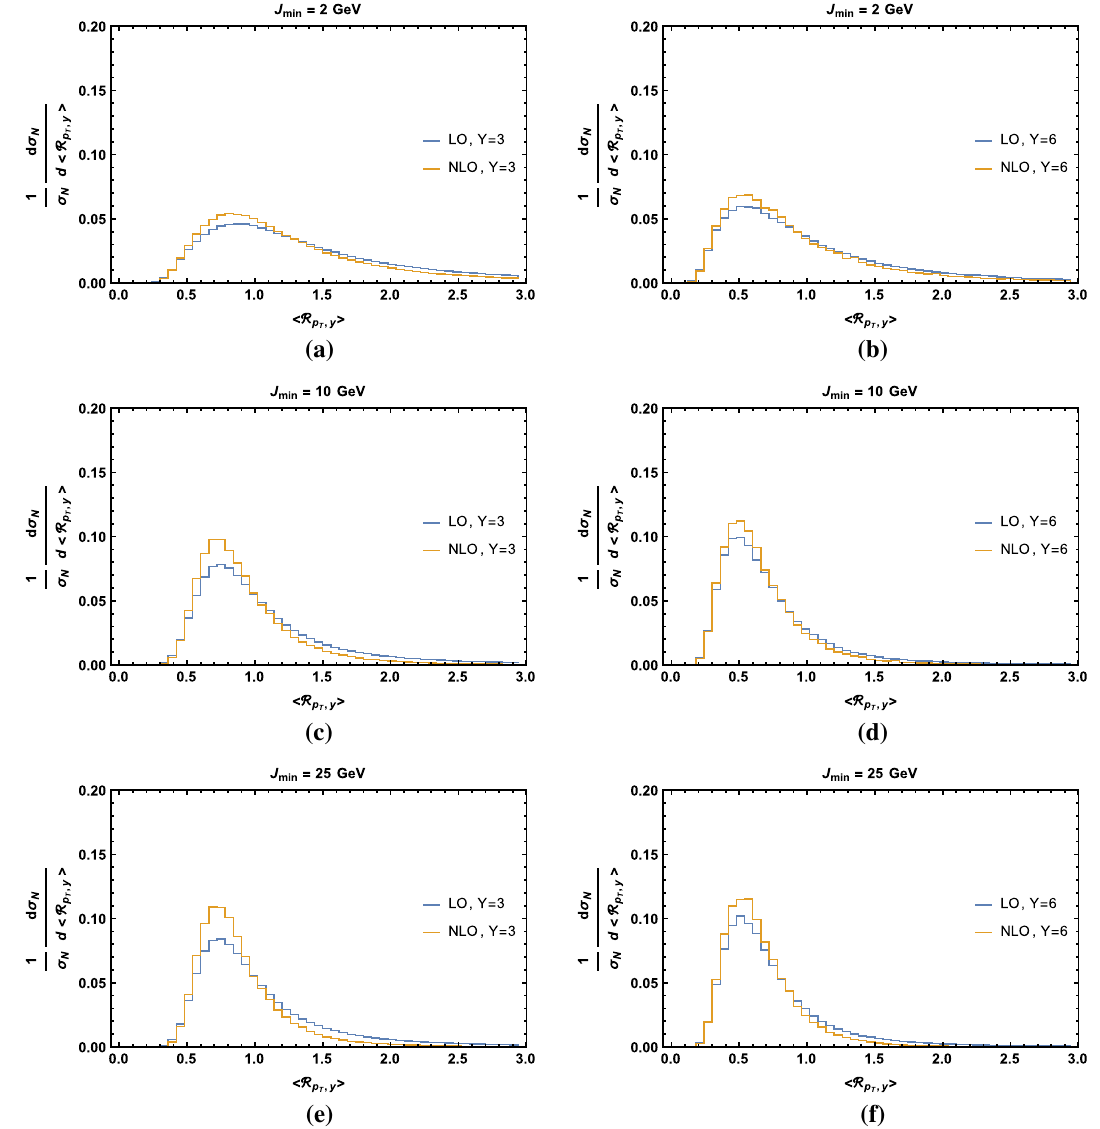
(cid:11) distributions for multiplicity N = 5, rapidity differences Y = 3 (left) and Y = 6 T , y